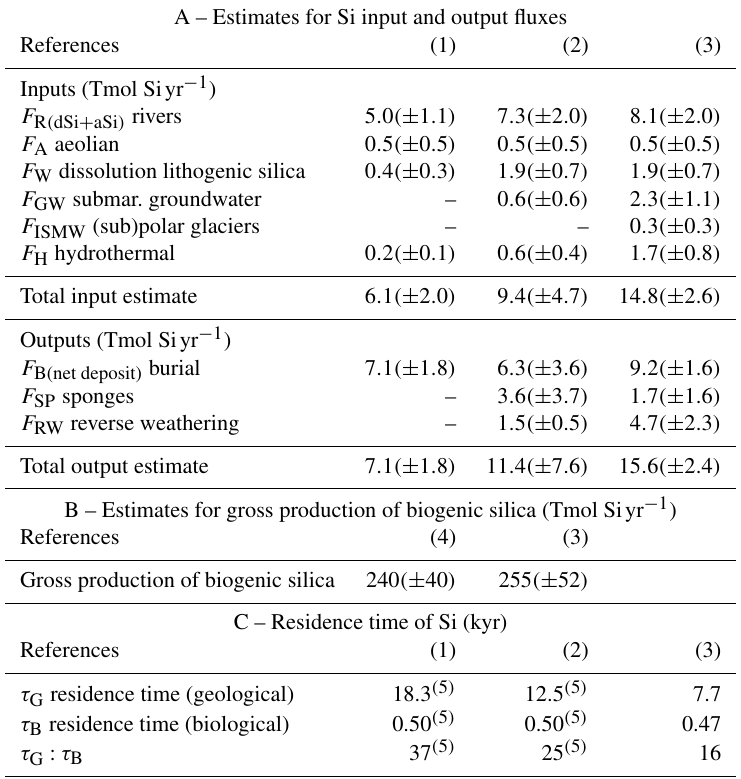
Table 3. A total of 25 years of evolution of the estimates for Si inputs, outputs, biological production, and residence times at World Ocean